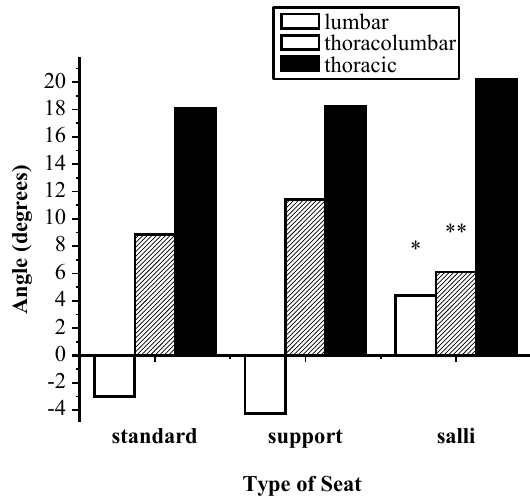
Figure 6 – Lumbar, thoraco-lumbar and thoracic angles recorded in the tree seat types (standard, ischial support and salli). *significant difference in relation to standard and ischial support seats; **signifi - cant difference in relation to ischial support seat.